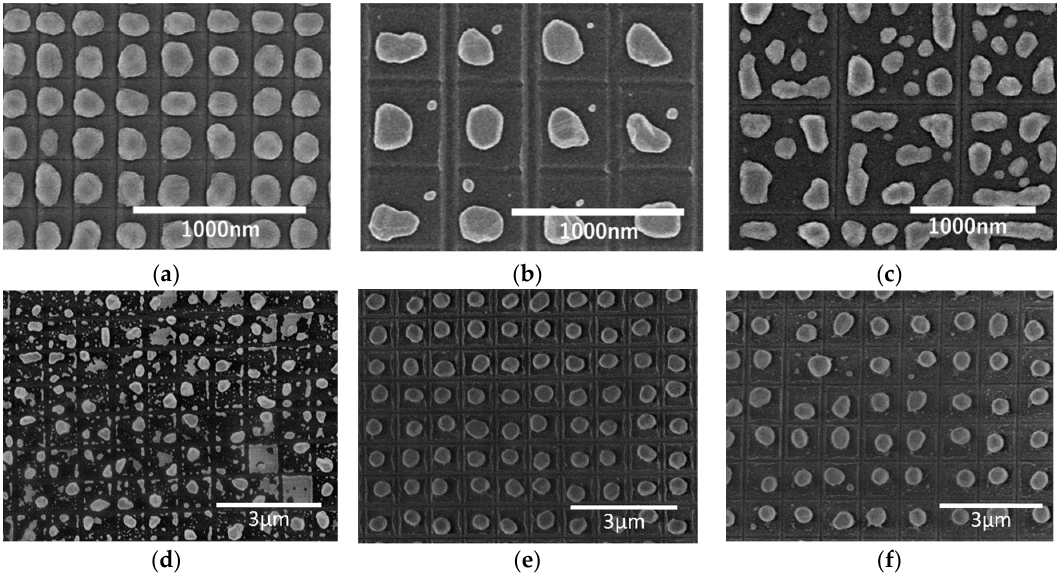
Figure 3. Field-emission scanning electron microscope (FE-SEM) micrographs of gold nanodot array generated by annealing; ( a ) t = 10 nm, P = 250 nm, T = 700 °C; ( b ) t = 10 nm, P = 500 nm, T = 700 °C; ( c ) t = 10 nm, P = 1000 nm, T = 700 °C; ( d ) t = 17 nm, P = 1000 nm, T = 700 °C; ( e ) t = 40 nm, P = 1000 nm, T = 1000 °C; ( f ) t = 40 nm, P = 1200 nm, T = 1000 °C.